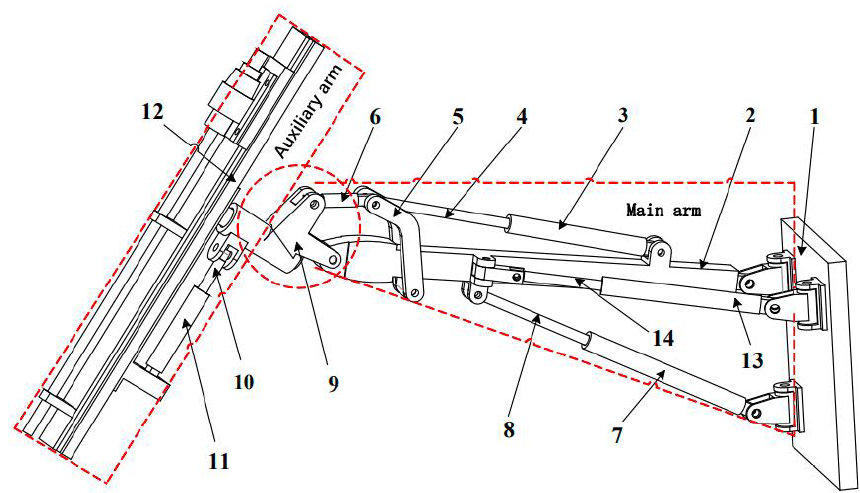
Figure 3. Spatial drill arm mechanism with 4 DOFs: (1) rack, (2) main boom, (3–4) auxiliary arm angle cylinder, (5) rocker, (6) connecting rod, (7–8) main arm lift cylinder, (9) auxiliary arm connecting rod, (10–11) auxiliary arm that turns the cylinder, (12) deputy boom and (13–14) main arm swing cylinder.